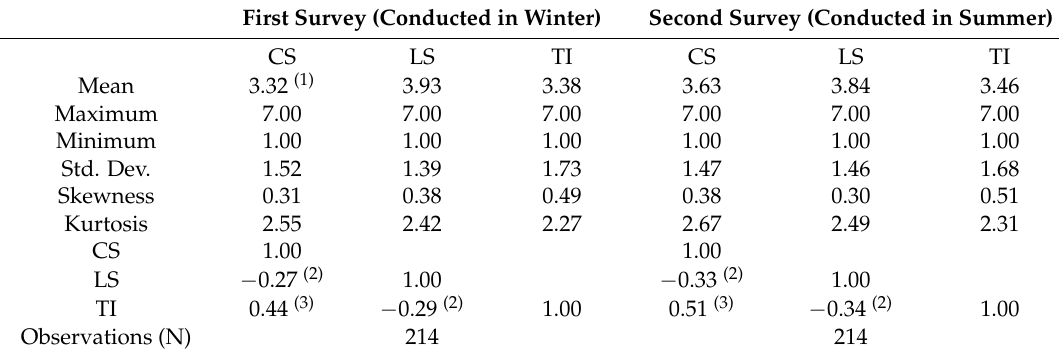
Table 11. Descriptive statistics and correlation matrix. (CS: Commuting stress, LS: Life satisfaction, TI: Turnover